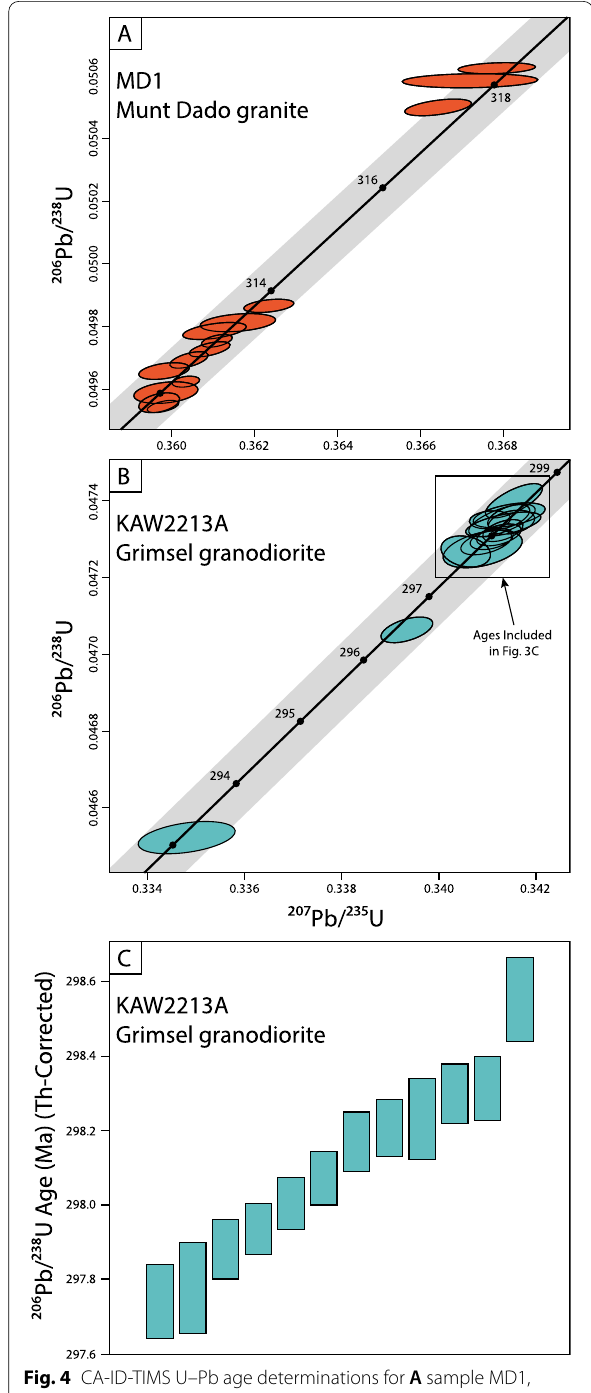
Fig. 4 CA-ID-TIMS U–Pb age determinations for A sample MD1, concordia diagram; B KAW2213A concordia diagram; C KAW2213A rank order plot for values at around 298